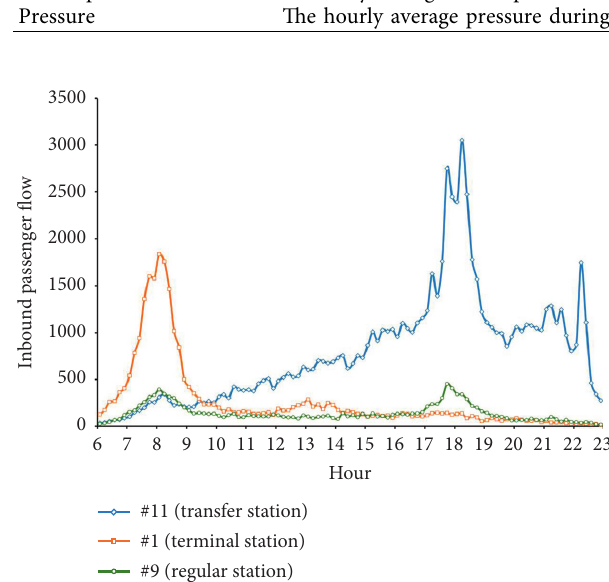
Figure 6: The temporal distribution of passenger flow for three typical station